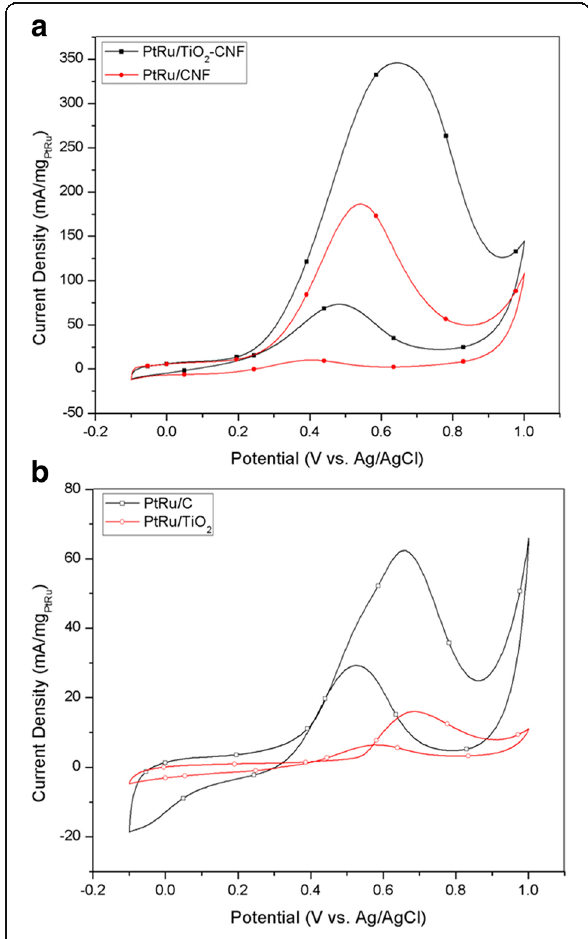
Fig. 4 CV in 2 M methanol and 0.5 M H 2 SO 4 at the scan rate of 20 mV s − 1 . a PtRu/TiO 2 -CNF and PtRu/CNF. b PtRu/C and PtRu/TiO 2